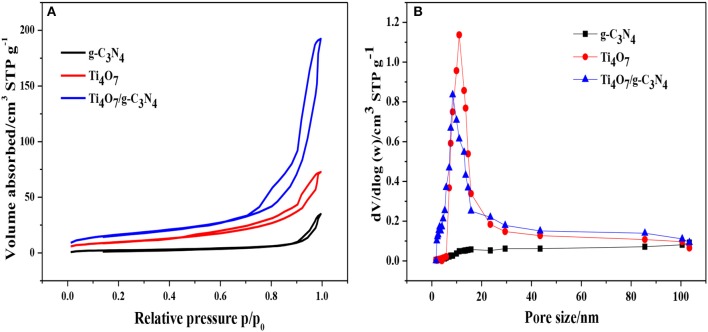
(A) N2 adsorption-desorption isotherms and (B) pore size distribution of g-C3N4, pure Ti4O7 and 1:2-Ti4O7/g-C3N4 photocatalysts.